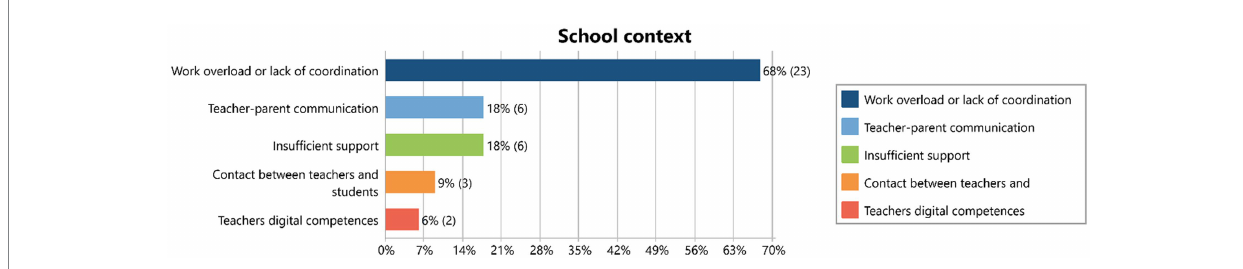
FIGURE 3 Frequency of documents referring to the subcategory School context, within the category Parents’